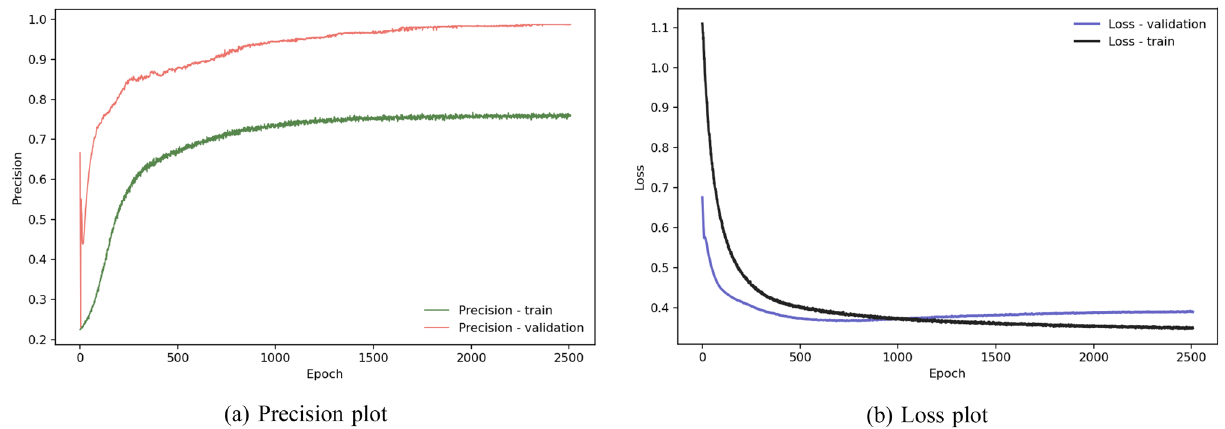
Figure 20. Deep learning model performance and